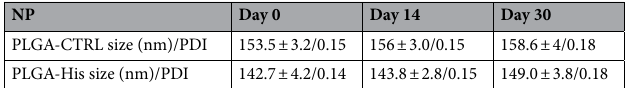
Table 2. PLGA-CTRL and PLGA-His stability at 4